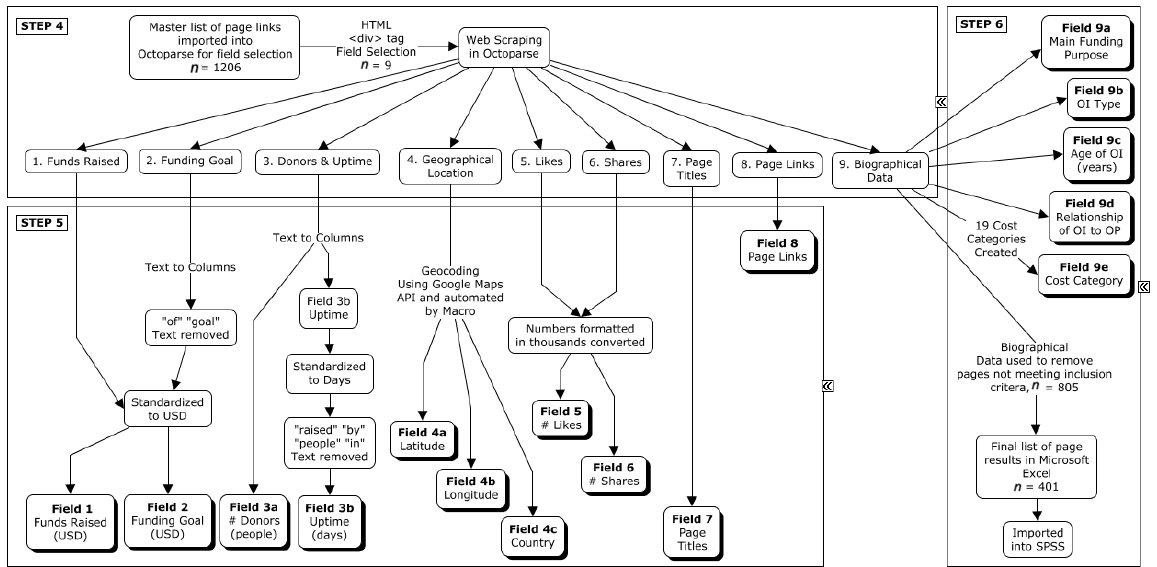
Figure 3. Flow diagram for Steps 4–6 of data collection method. # Donors (people) refers to the